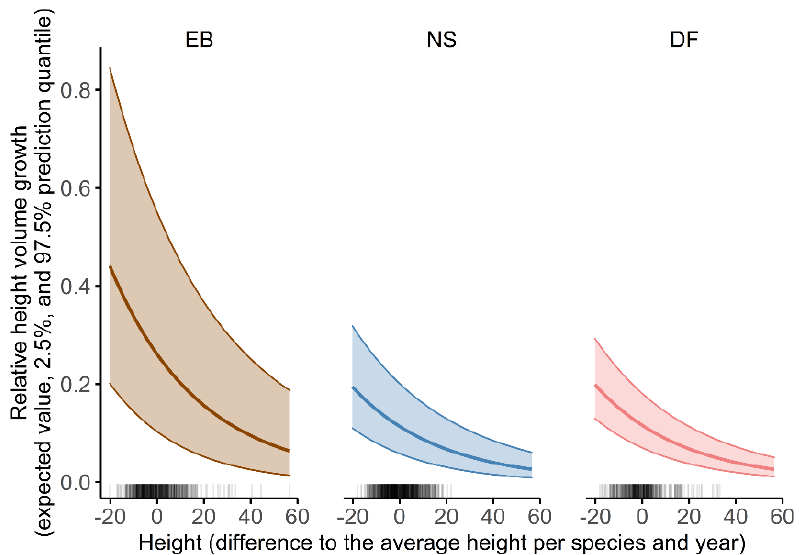
Figure 5. Predicted probability distributions (expected value, 2.5%, and 97.5% quantile) of the relative height volume growth (R) of European beech (EB), Norway spruce (NS), and Douglas fir (DF) with different heights. The predictions were based on the location-scale regression model (Equation (2)). All other covariates were fixed to a representative value.